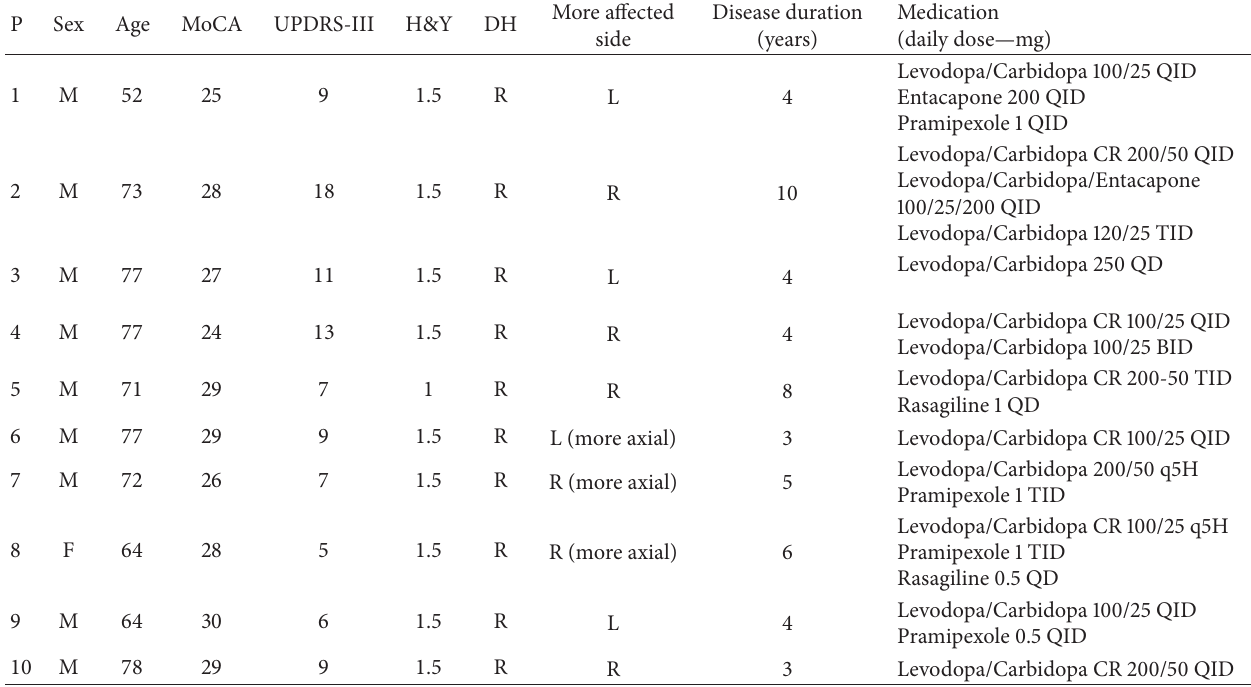
Table 1: Participant